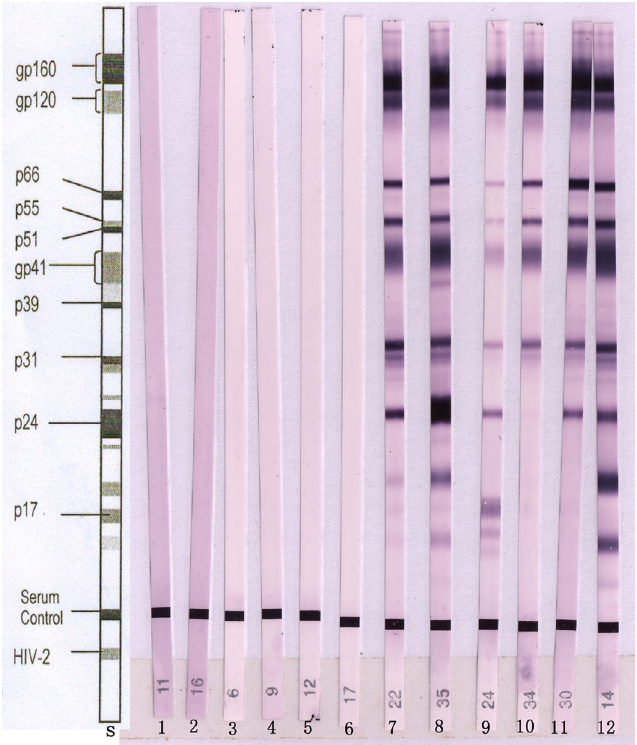
Figure 3. Western blot analysis of false-positive results and early HIV infections after follow-up for 2 weeks to 3 months. S standard line. Lanes 1–6: sera obtained from patients with false-positive results, showing no bands or only a P24 band for specific antigens of HIV-1. Lanes 7–12: sera obtained from patients with early HIV infection, showing more than two distinct bands for specific antigens of HIV-1.